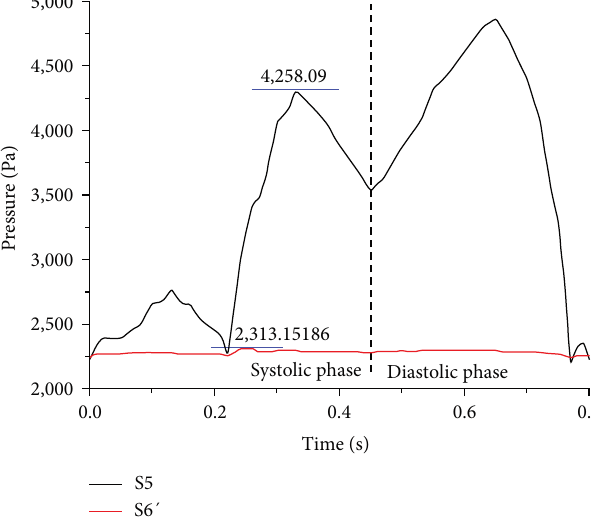
F IGURE 4: Pressures at both ends of the stenosis with the Newtonian fl uid